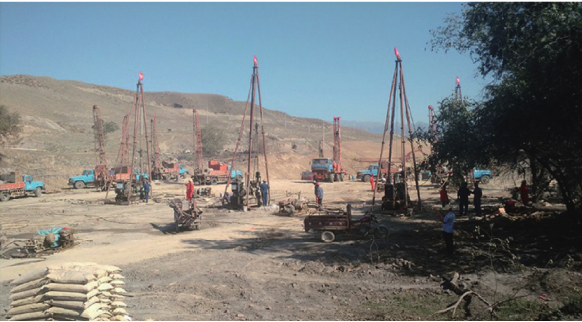
Figure 2: Construction site